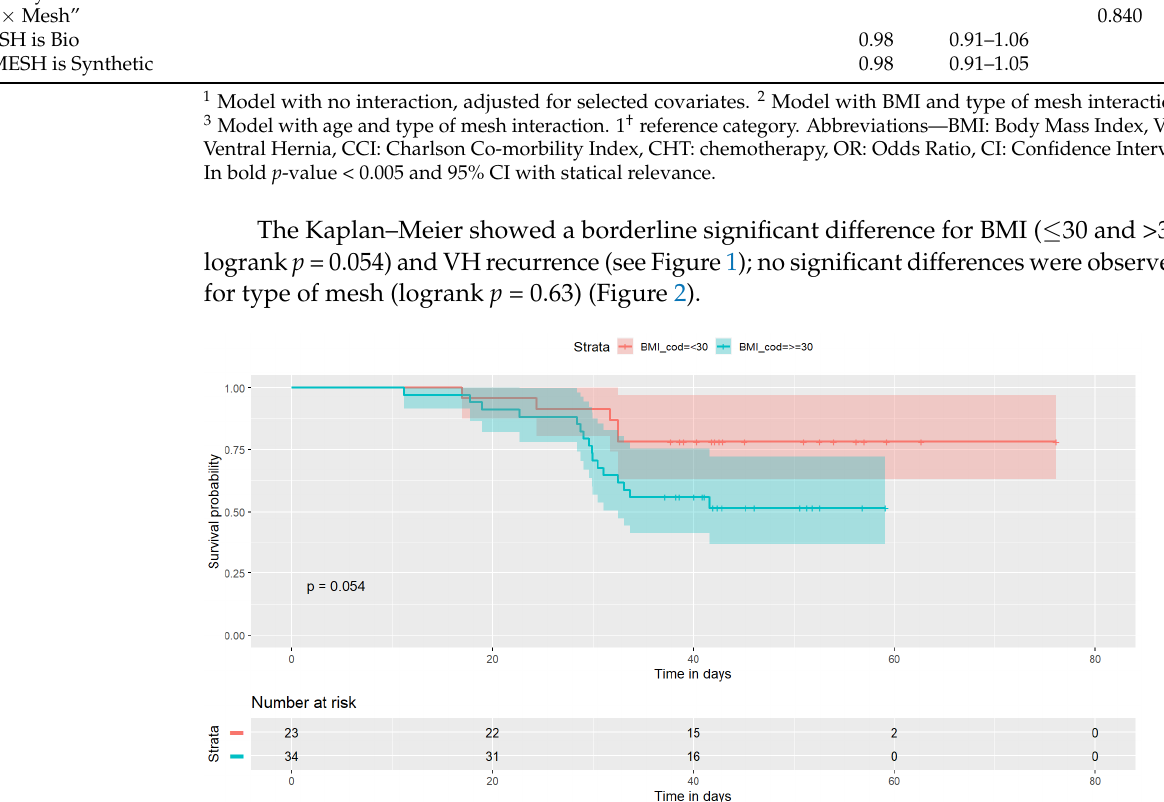
Figure 1. Kaplan–Meier chart stratified for BMI.